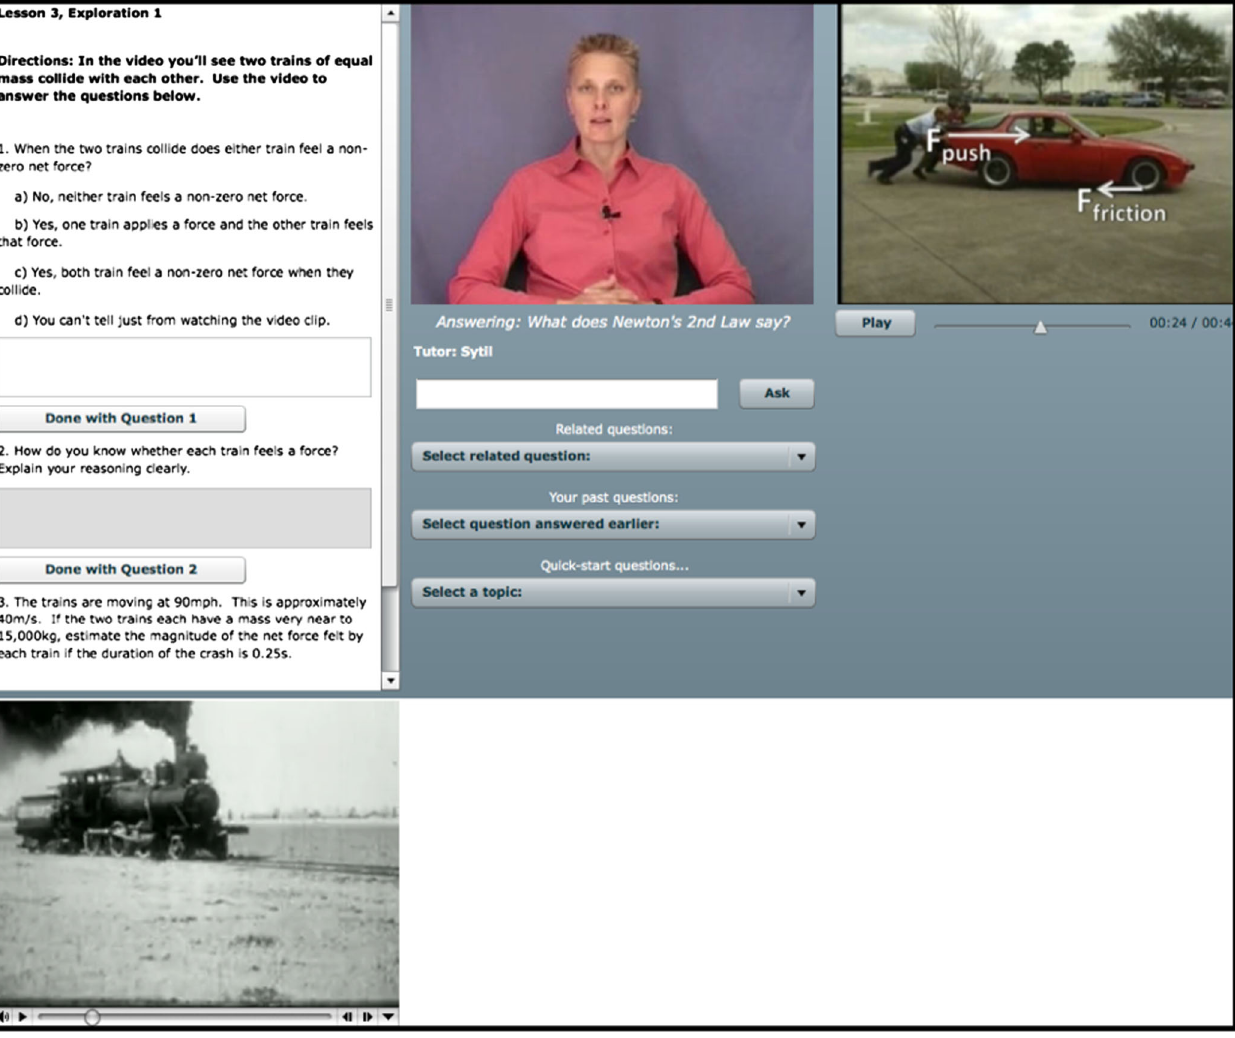
FIG. 1. The Pathway Active Learning Environment interface: The lesson activities and relevant video clip can be seen on the left. The SI tutor can be seen in the center of the interface. At the right a sample video supplementing the tutor ’ s explanation is